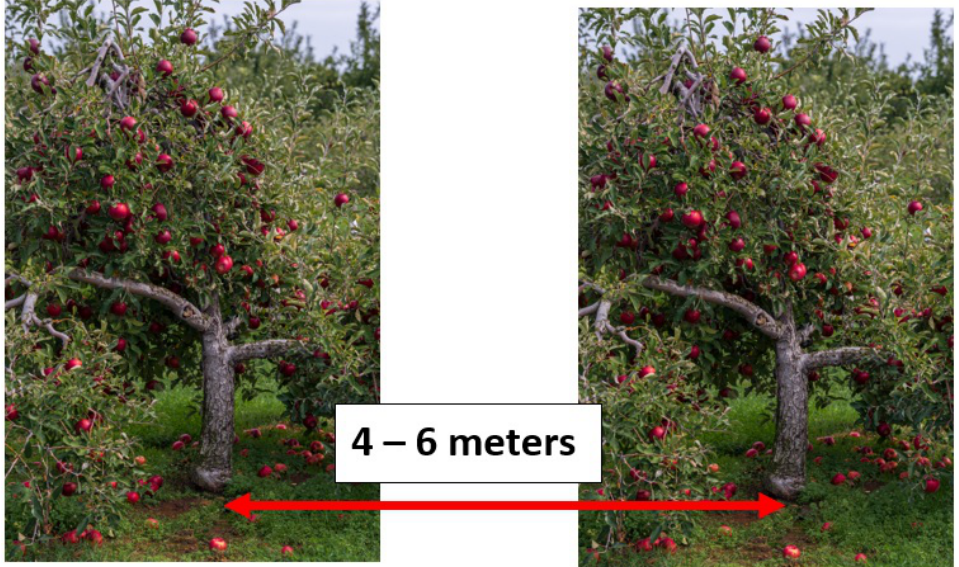
Figure 1. The optimal distance between two rows of apple trees. The distance also depends on the apple types and hence the imaging should be able to capture the apple information from 6